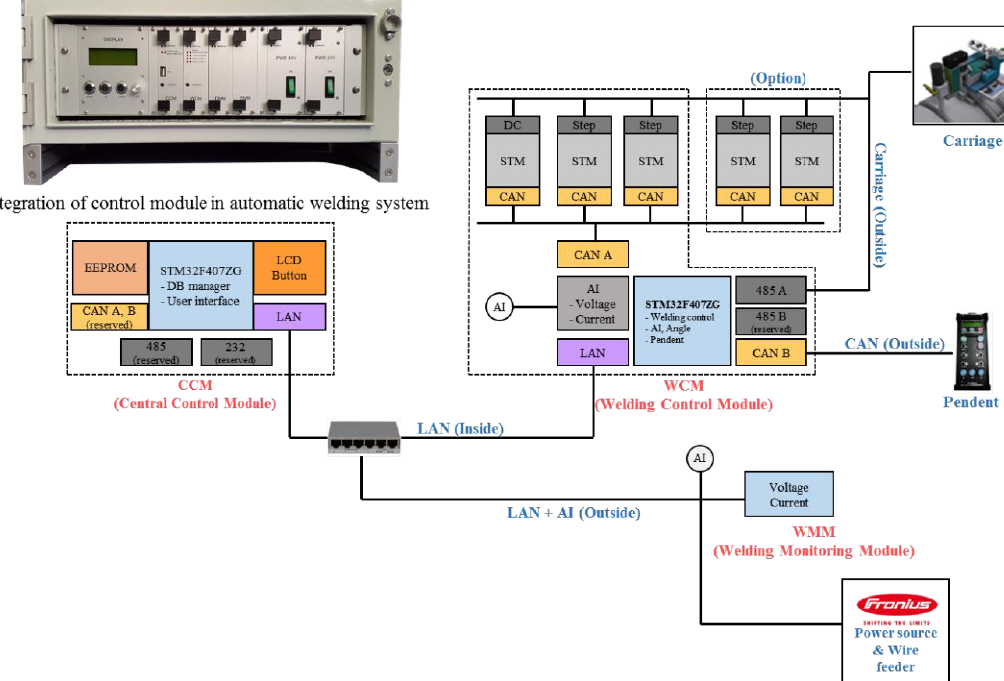
Figure 4. Block diagram of the automatic welding control system.